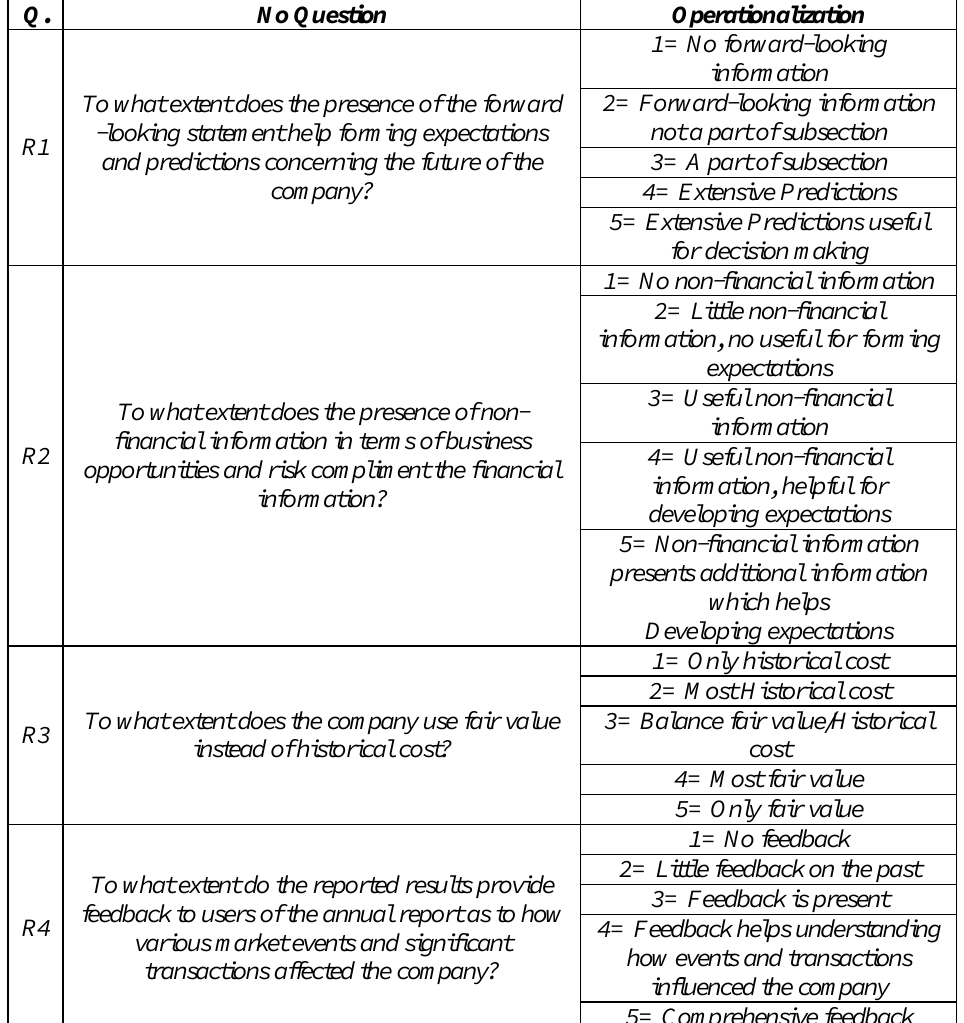
Table 6. Measures to be used to Operationalize the Fundamental and Enhancing Qualitative Characteristics (including the Measurement